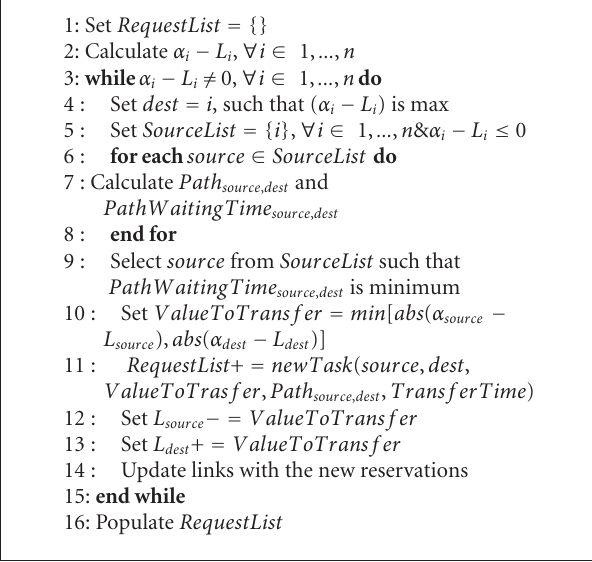
Algorithm 1: Resource allocation greedy